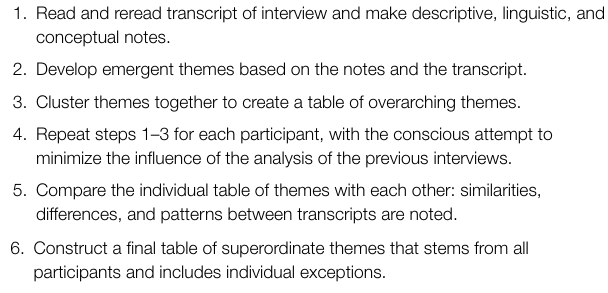
TABLE 2 | Step-by-step procedure for interpretative phenomenological